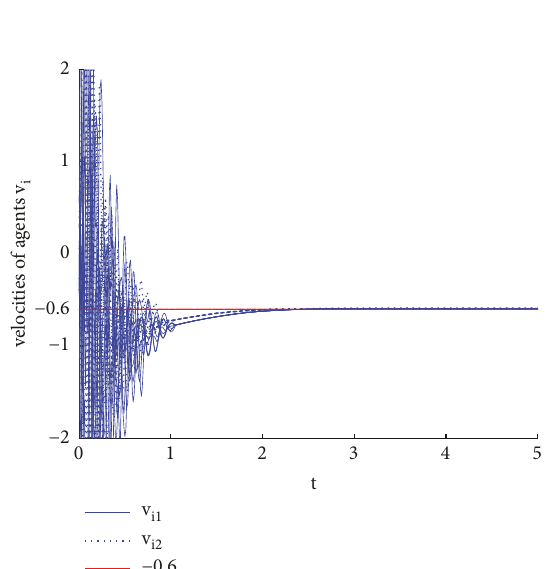
Figure 5: Velocities of all